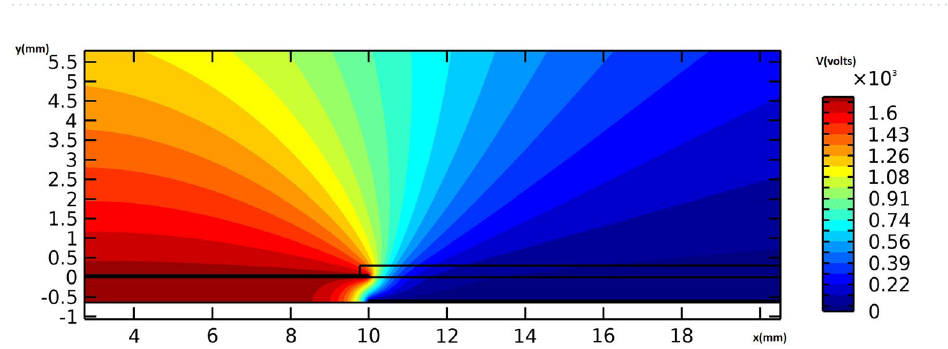
Figure 8. The electric potential field around the actuator in volts, for the actuation case of V = 6 kVpp and f = 8 kHz.